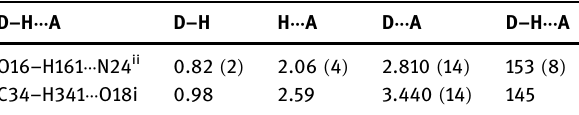
Table 3: : Hydrogen - bond geometry ( Å and ° ) of complex